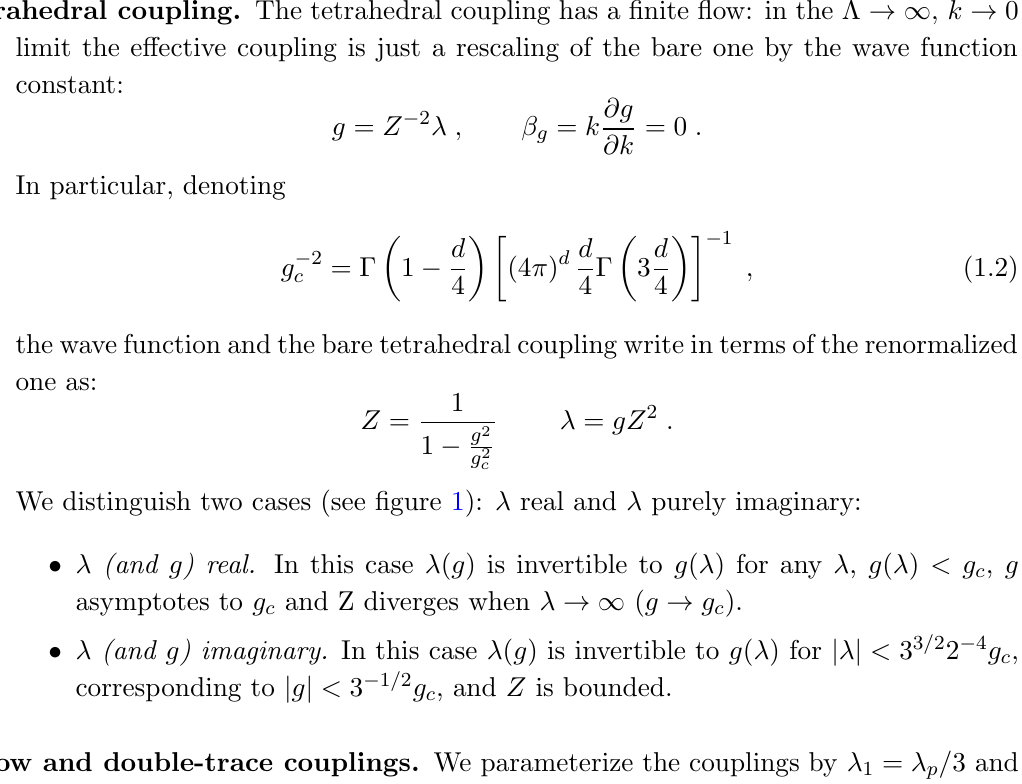
Figure 1 . The bare coupling as a function of the renormalized one. We represented in black the case (cid:21) real, and in blue the absolute value in the case (cid:21) purely imaginary. that is, the renormalized mass can be tuned to zero and the wave function renor- malization is a (cid:12)nite rescaling. This should come as no surprise: we have (cid:12)xed the scaling of the covariance to the infrared scaling, hence we do not get an additional anomalous scaling from a wave function